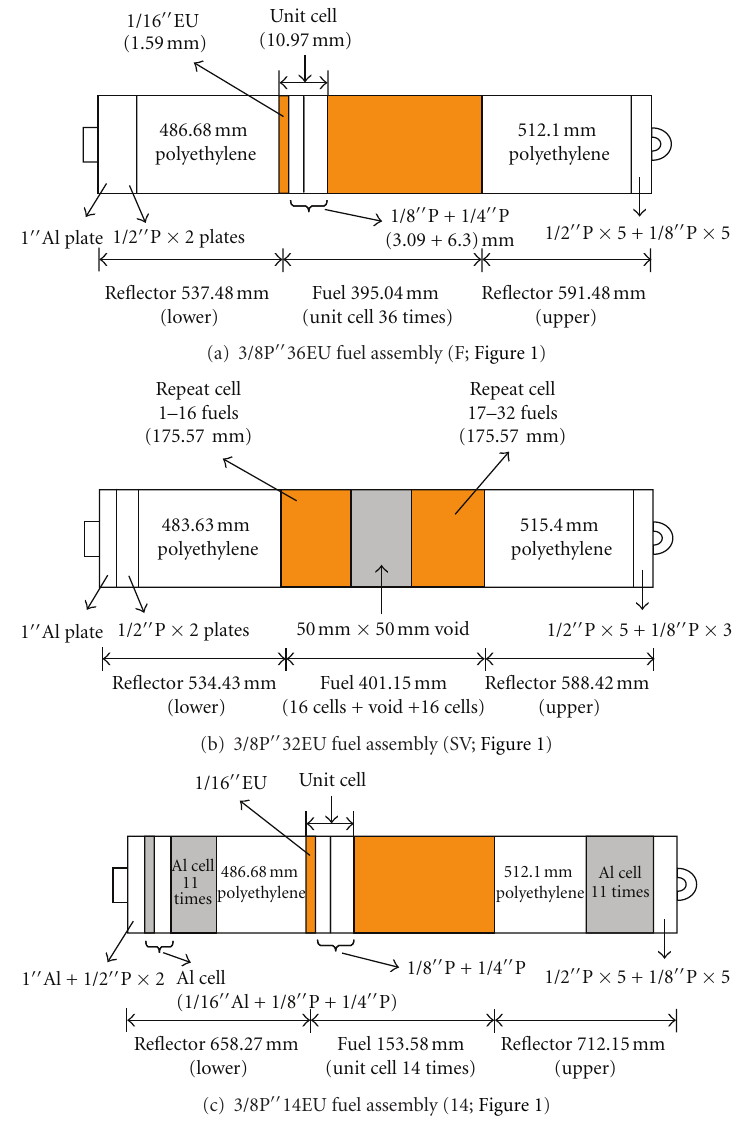
Figure 2: Schematic drawing of fuel assemblies in the A-core.